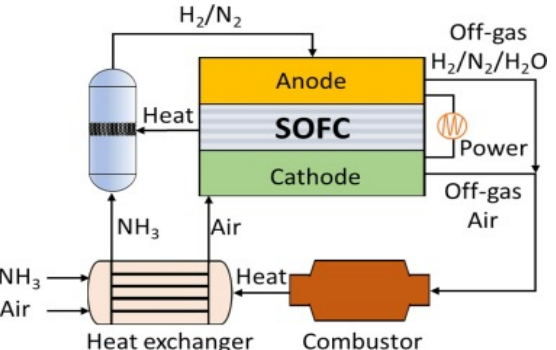
Figure 26. Schematic reactor integrated with SOFCs with combined heat, power and rate of ammonia decomposition [113,114].